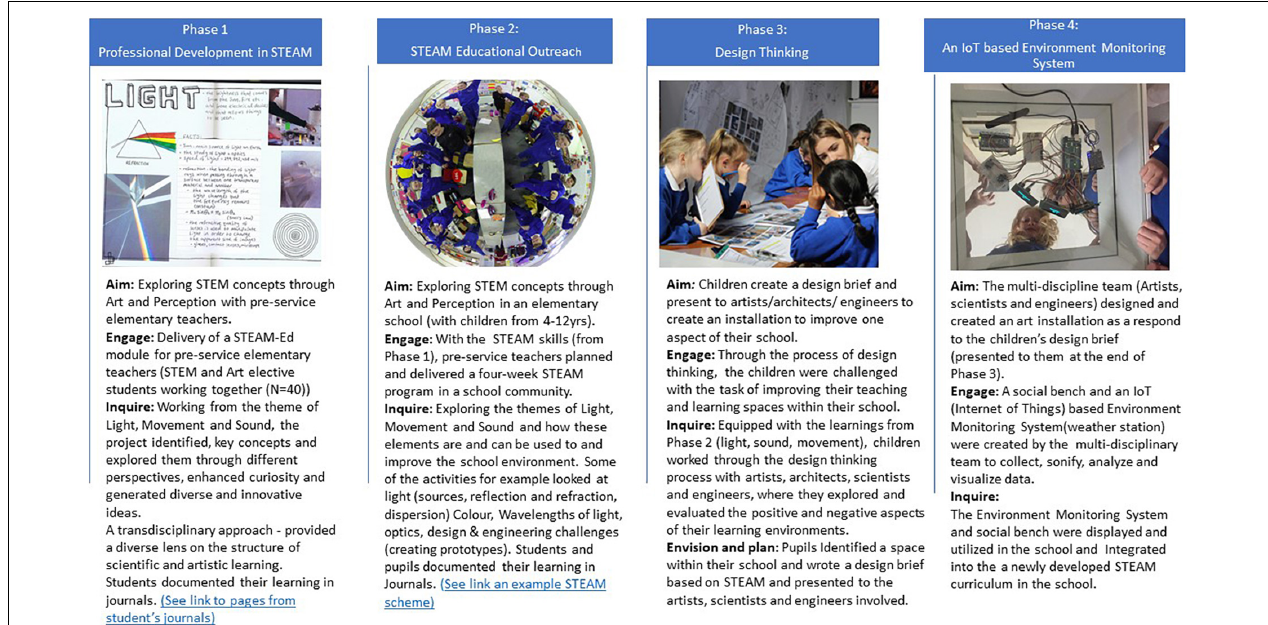
FIGURE 1 | Four stages of the STEAM-ED Project. Image in phase 3 panel from Morrin and Liston